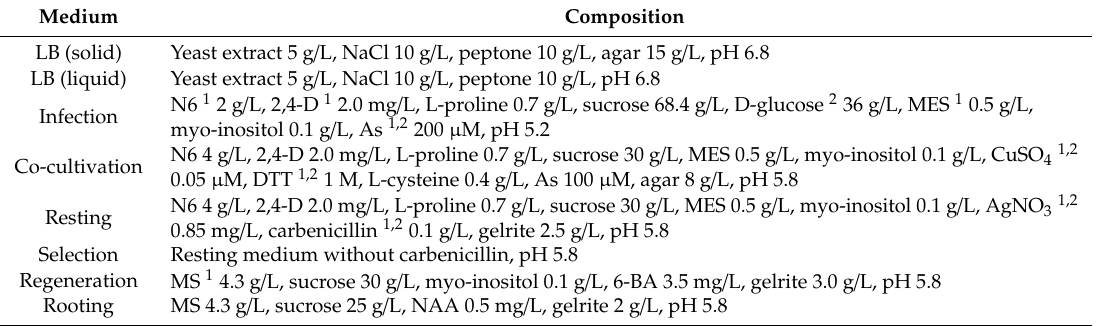
Table 1. Composition of media used in Agrobacterium -mediated